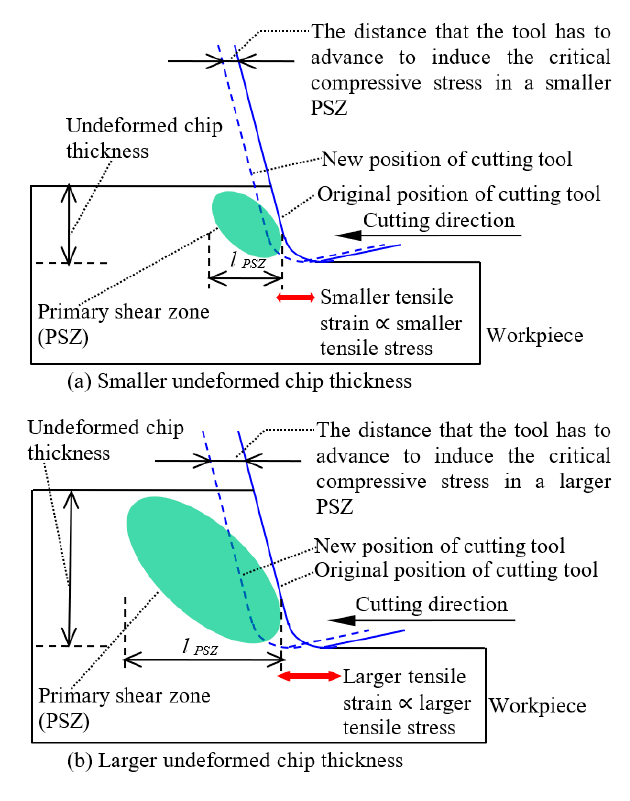
Figure 2. Illustration of how undeformed chip thickness affects the stress states.